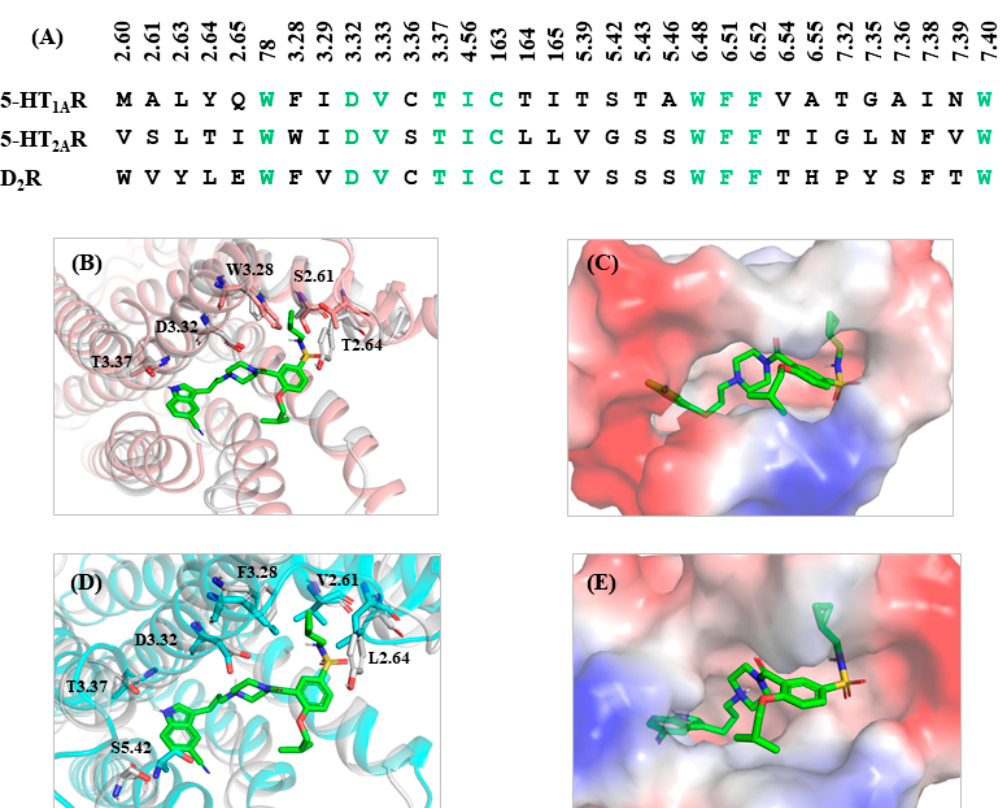
Figure 3. ( A ) Sequences of 5-HT 1A R, 5-HT 2A R, and D 2 R at the binding site. ( B ) The superimposition of 5-HT 2A R with 13m -bound 5-HT 1A R. ( C ) Electrostatic potential energy diagram of 13m and 5-HT 2A R at the binding site. ( D ) The superimposition of D 2 R with 13m -bound 5-HT 1A R. ( E ) Electrostatic potential energy diagram of 13m and D 2 R at the binding site. The ligand is shown as green sticks. 5-HT 1A R and the surrounding residues are in gray. 5-HT 2A R and the surrounding residues are in pink. D 2 R and the surrounding residues are in blue.